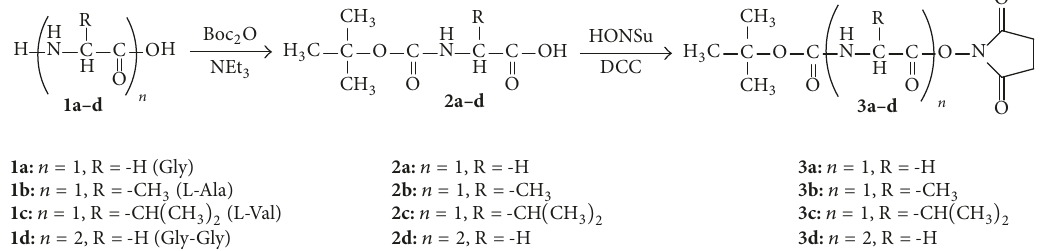
Figure 1: Preparation of N -t-butyloxycarbonyl-amino acid and peptide active esters. Boc 2 O: di-tert-butyl dicarbonate; NEt 3 : triethylamine; HONSu: N -hydroxysuccinimide; DCC: N,N 󸀠 -dicylohexylcarbodiimide.